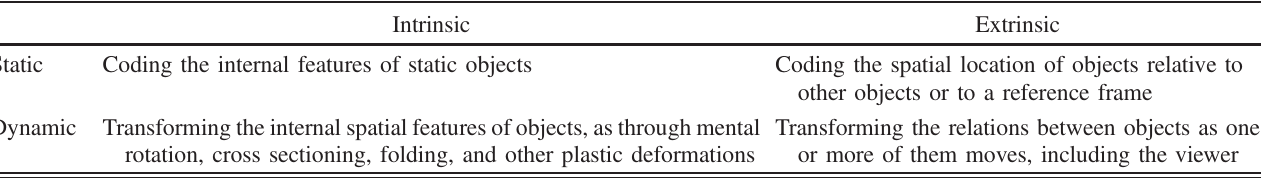
TABLE II. Newcombe-Shipley topology of spatial skills [62]. Intrinsic Static Coding the internal features of static objects Coding the spatial location of objects relative